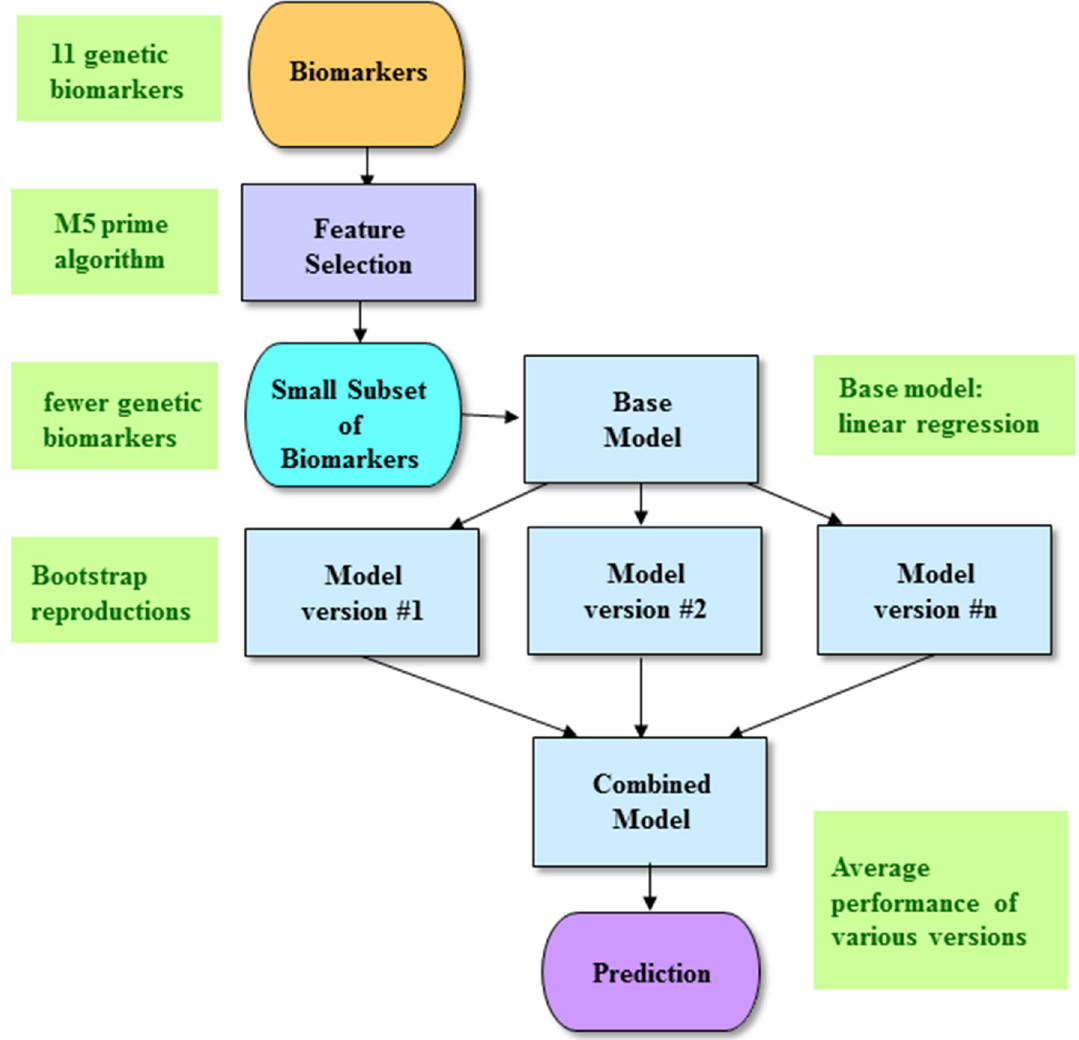
Figure 1. The schematic illustration of the bagging ensemble machine learning method with feature selection. First, the M5 Prime feature selection algorithm is conducted to find a small subset of biomarkers, which serves as the input to the bagging ensemble machine learning method. The concept of the bagging ensemble machine learning method is to create the multiple versions of a base model by bootstrap reproductions. Then, the ultimate prediction is generated by averaging the predictive performance of the multiple versions. The base model was chosen as linear regression in this